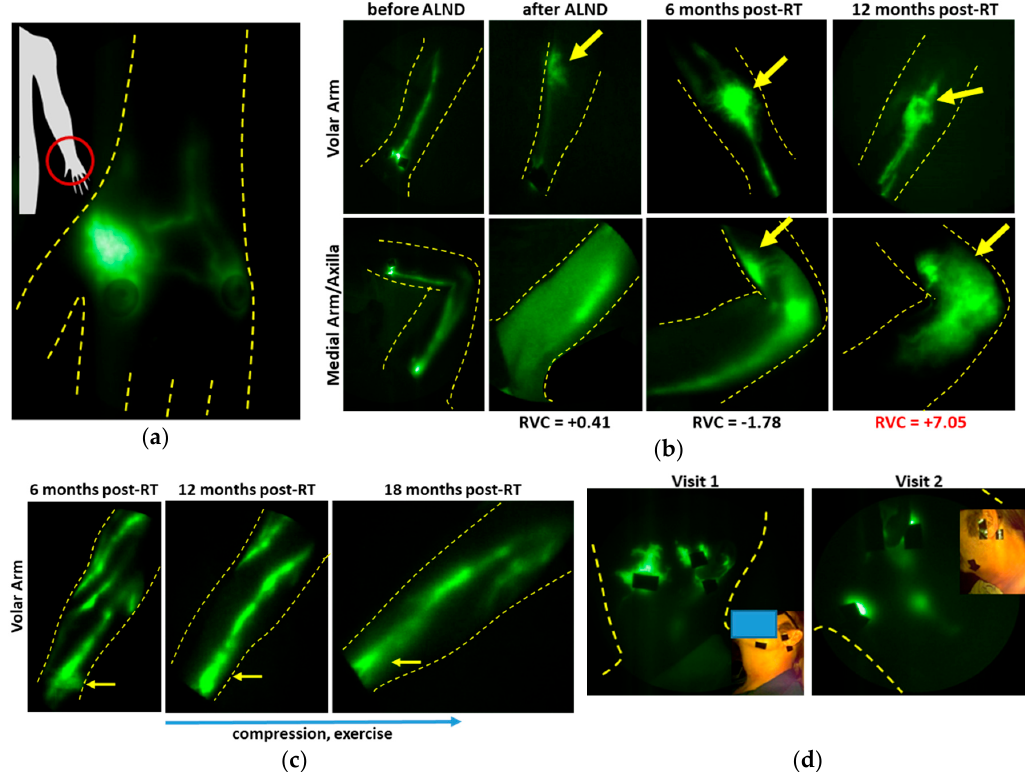
Figure 9. Images of lymphatics in breast ( a – c ) and head and neck ( d ) cancer survivors. ( a ) A region of “heaviness” but no swelling manifesting dermal backflow. ( b ) Dermal backflow observed longitudinally before the relative volume change (RVC) is more than 5%, which is the threshold for clinical diagnosis. ( c ) Resolution of dermal backflow after commencement of compression and exercises. ( d ) Resolution of dermal backflow after two weeks of advanced pneumatic compression device (APCD) therapy (adapted from [92], Gutierrez, C., et al., 2019). Injection sites are covered with round bandages and/or black vinyl tape. The brightness and contrast of the images have been adjusted to facilitate the visualization of the 16-bit imaging depth.